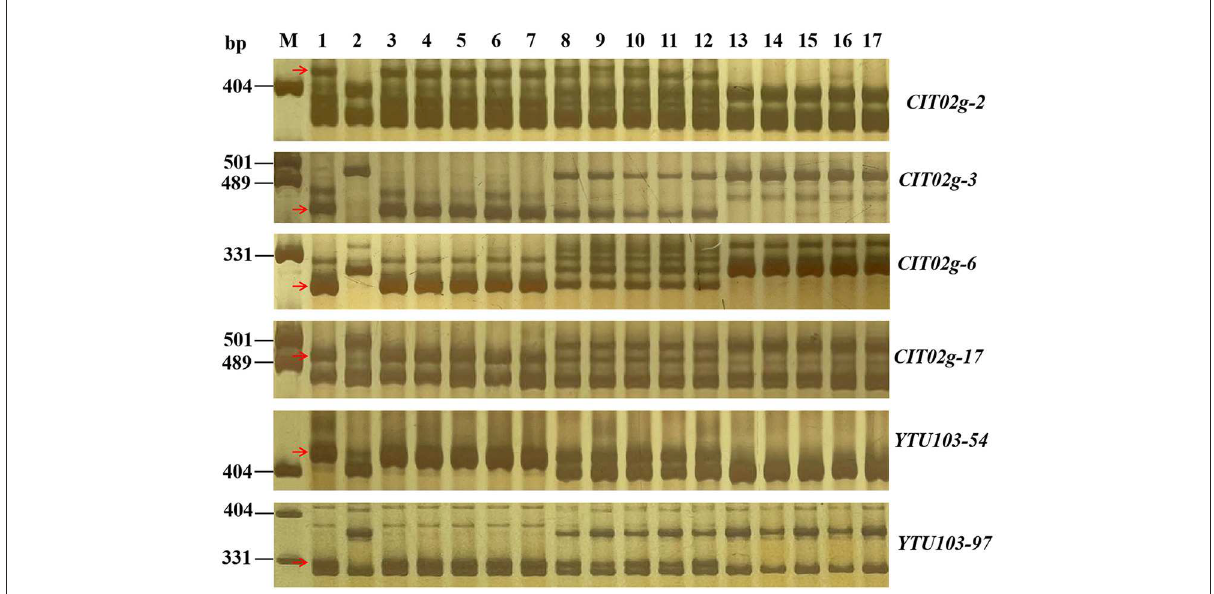
FIGURE3 Amplification patterns of pmYN99102 -linked markers CIT02g-2 (A), CIT02g-3 (B), CIT02g-6 (C), CIT02g-17 (D), CIT02g-54 (E) and YTU103-97 in genotyping resistant parent Yannong 99102-06188 (YN99102), susceptible parent Jinhe13–205 (JH13–205) and randomly selected F 2 : 3 families of YN99102 × JH13–205. Lane M, pUC18 Msp I; lanes 1–2, YN99102 and JH13–205; lanes 3–7, homozygously resistant F 2 : 3 families; lanes 8–12, heterozygously F 2 : 3 families; lanes 13–17, homozygously susceptible F 2 : 3 families. The red arrows were used to indicate the polymorphic bands linked to pmYN99102